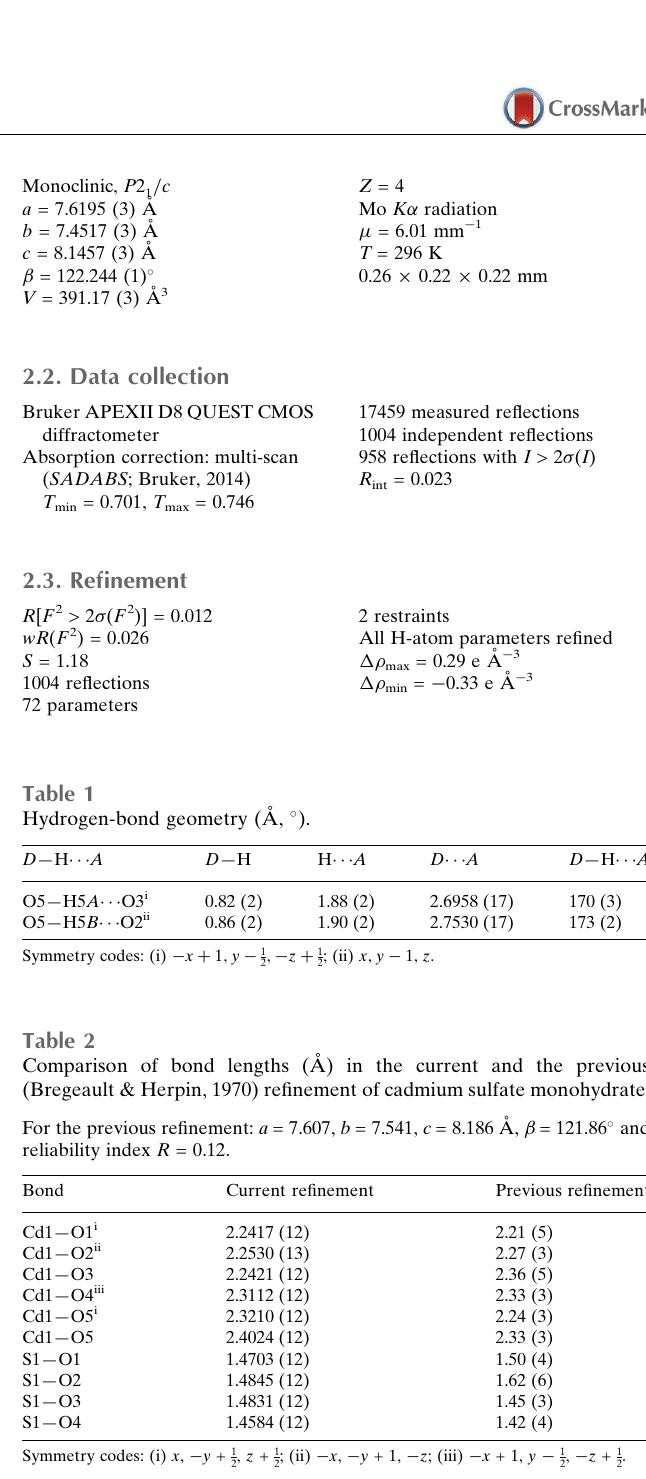
refine structure: SHELXL2014 (Sheldrick, 2015); molecular graphics: OLEX2 (Dolomanov et al. , 2009); software used to prepare